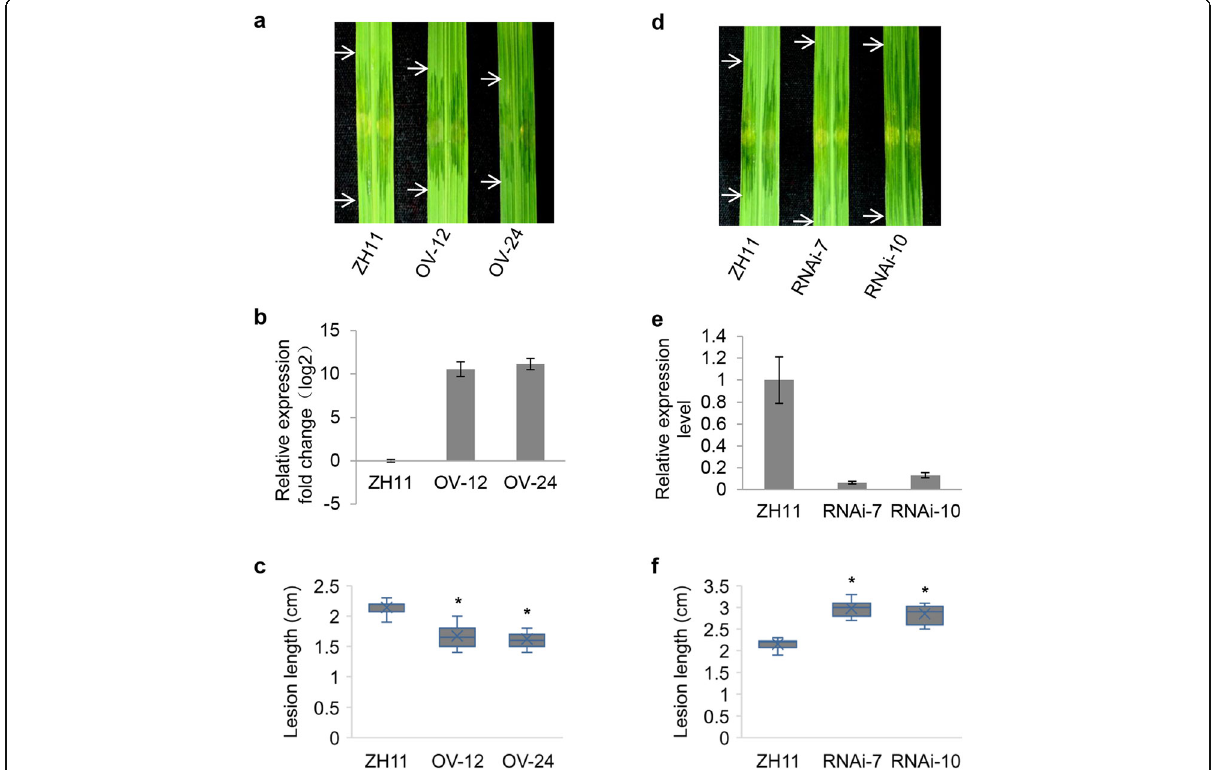
Fig. 2 OsPGIP1 contributes to bacterial leaf streak resistance. a The phenotypes of the RS105 lesions that developed on ZH11 and two OsPGIP1 - overexpressing lines (OV-12 and OV-24) at 14 days after infiltration. The arrows represent the boundaries of lesion expansion caused by RS105 infection. b Relative expression fold change of OsPGIP1 in OV-12 and OV-24. The expression of wild-type ZH11 was used as a control and set to 1. The housekeeping gene ACTIN was used to normalize the data. c The lesion lengths of ZH11, OV-12 and OV-24 at 14 days after inoculation with RS105. d The phenotypes of the RS105 lesions that developed on ZH11 and two OsPGIP1 -suppressed lines (RNAi-7 and RNAi-10) at 14 days after infiltration. The arrows represent the boundaries of lesion expansion caused by RS105 infection. e Relative expression level of OsPGIP1 in RNAi-7, RNAi-10 and ZH11. The expression of wild-type ZH11 was used as a control and set to 1. ACTIN was an internal reference gene for normalization. f The lesion lengths of ZH11, RNAi-7 and RNAi-10 inoculated with RS105 after 14 days. Data were analyzed using a t -test. Asterisks represent statistically significant differences from the ZH11 wild type at P <